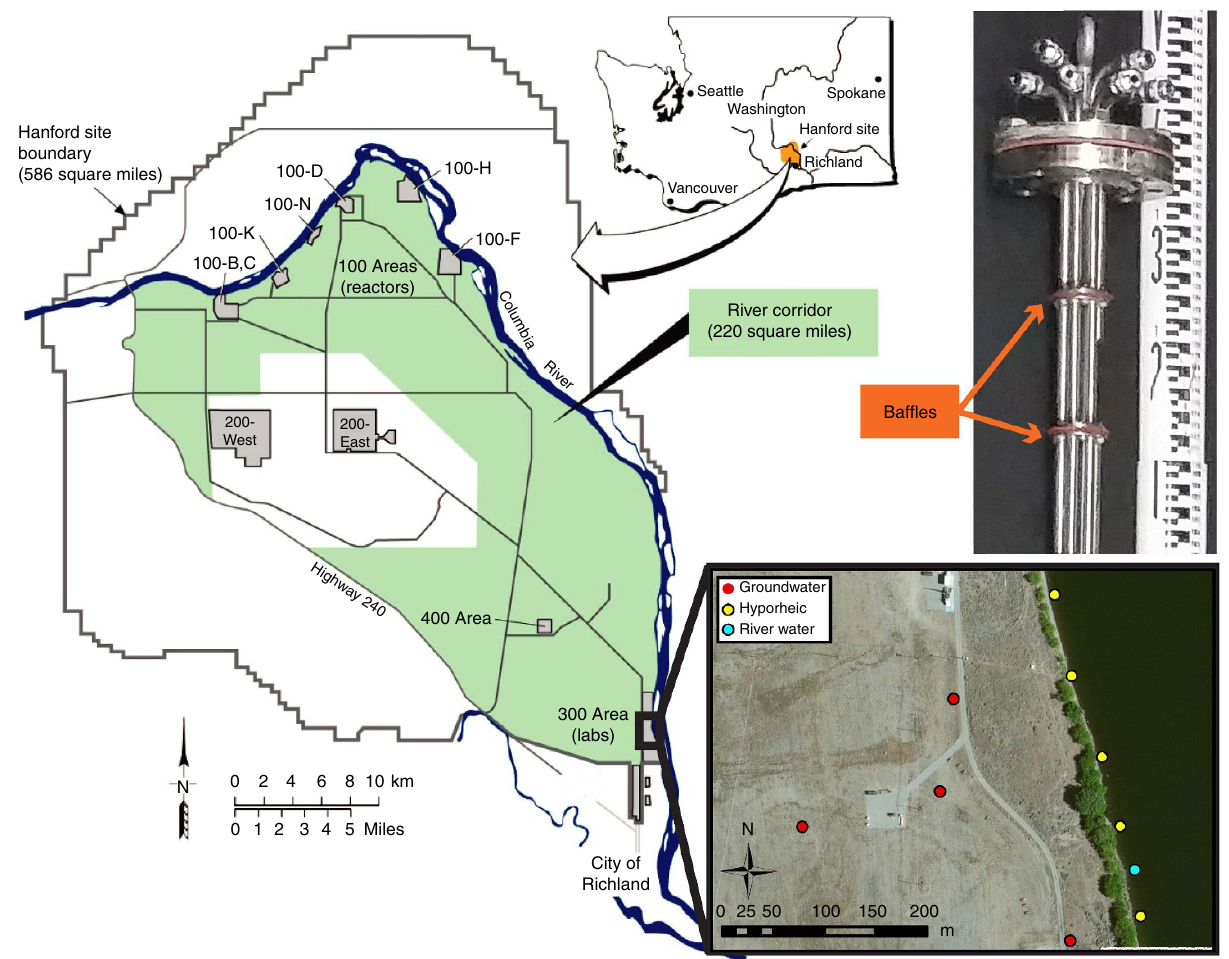
Figure 1 | Sampling locations and infrastructure. Map showing sampling locations in the Hanford 300 Area. Also displayed is the top 30cm of the multi-level sampling device used to sample riverbed piezometers; baffles separating vertical zones are noted; tubes for water collection were terminated within each vertical